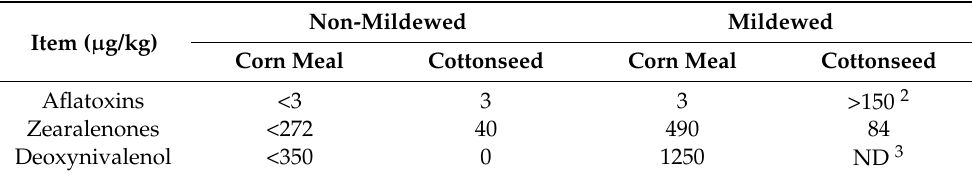
Table 2. Comparison of major mycotoxins’ levels ( µ g/kg dry matter) 1 in corn meal and cottonseed naturally mildewed and non-mildewed. Non-Mildewed Mildewed Item ( µ g/kg) Corn Meal Cottonseed Corn Meal Cottonseed